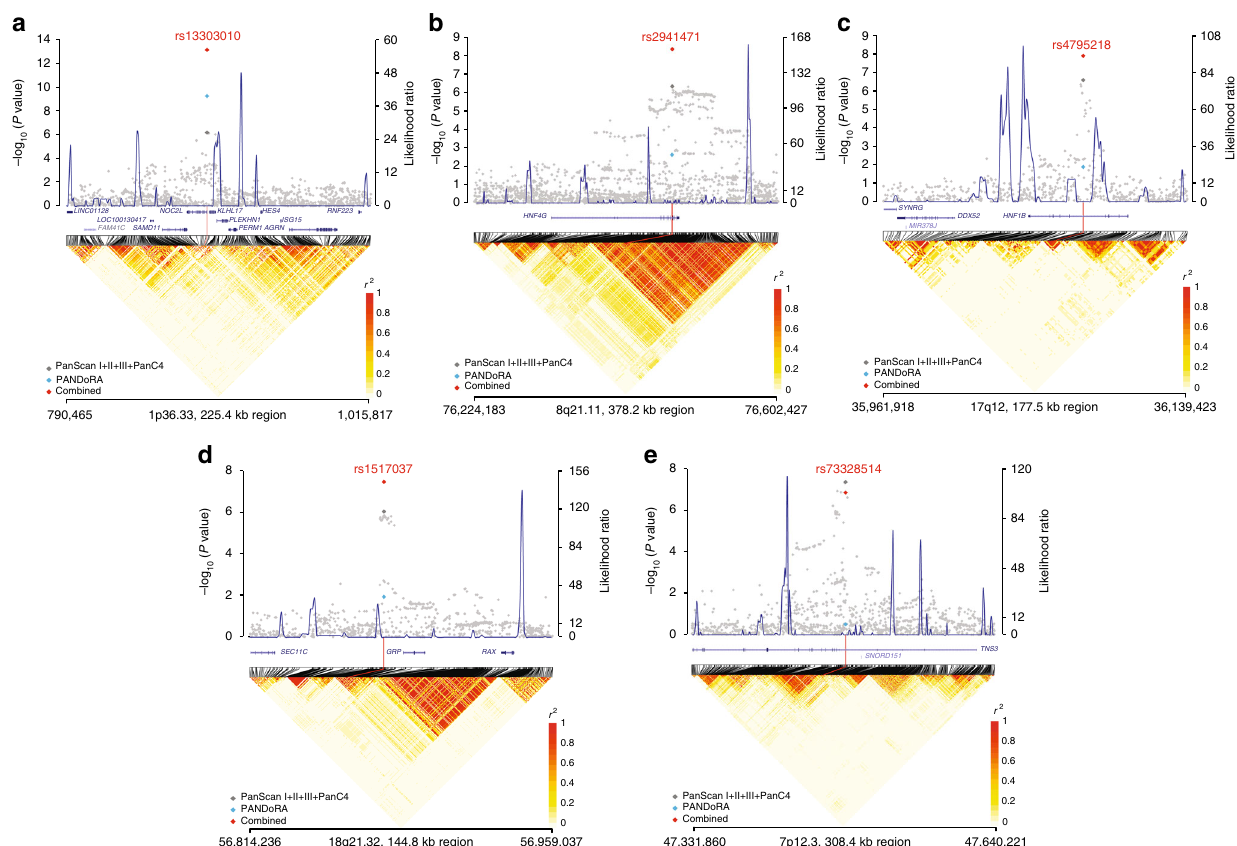
Fig. 1 Association results, recombination hotspots, and LD plots for new pancreatic cancer susceptibility regions. The top half of each panel shows the association results for the meta-analysis of PanScan I+II, PanScan III, and PanC4 (gray diamonds). The results for the replication of the marker SNP at each locus are shown for PANDoRA (light blue diamonds) and the combined meta-analysis results (red diamonds). Overlaid are likelihood ratio statistics estimating putative recombination hotspots across the region based on the inference using the CEU 1000 G Phase 3 data. Genomic coordinates are plotted on the x axis (Genome build hg19), P values for the association analysis are shown on the left y axis, and recombination hotspot likelihood ratio on the right y axis. The bottom half of each panel shows LD heat maps based on r 2 values from the 1000 G Phase 3 CEU population for all variants included in the analysis. Shown are results for chromosomes 1p36.33 ( a ), 8q21.11 ( b ), 17q12 ( c ), 18q21.32 ( d ), and 7p12 ( e